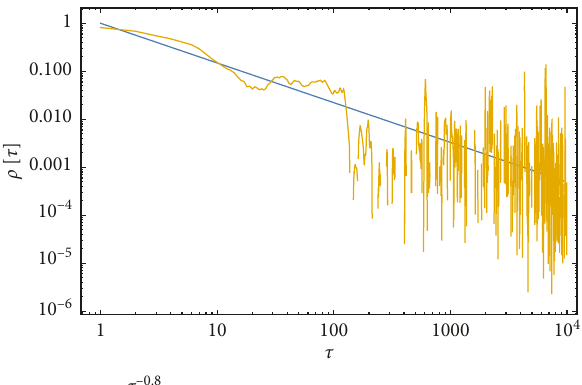
Figure 3: Log-log plot of the ACF for τ I